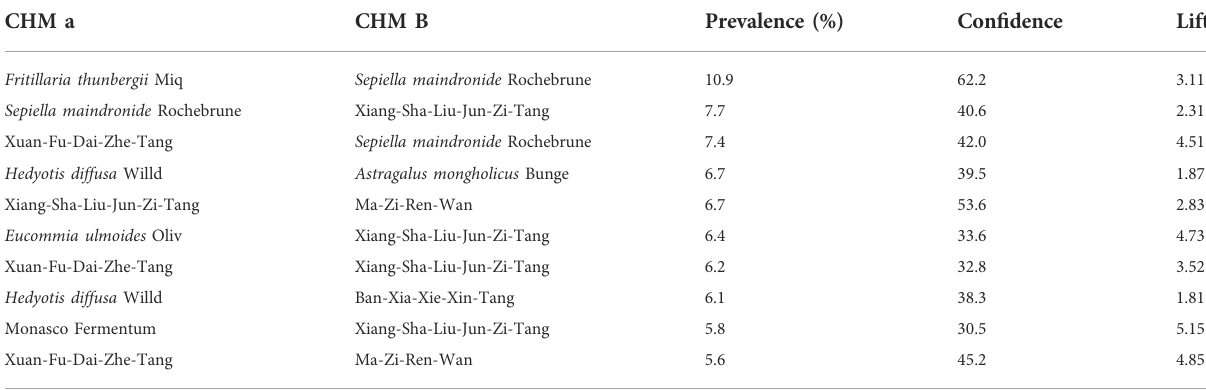
TABLE4 Thetopten twoCHMcombinations forstage IVesophagealcancer.Prevalence wasthepercentageofeachcombinationofallprescriptions (n = 676). Con fi dence and lift presented the strength of each combination, and a higher value represented stronger connections between CHMs. CHM a